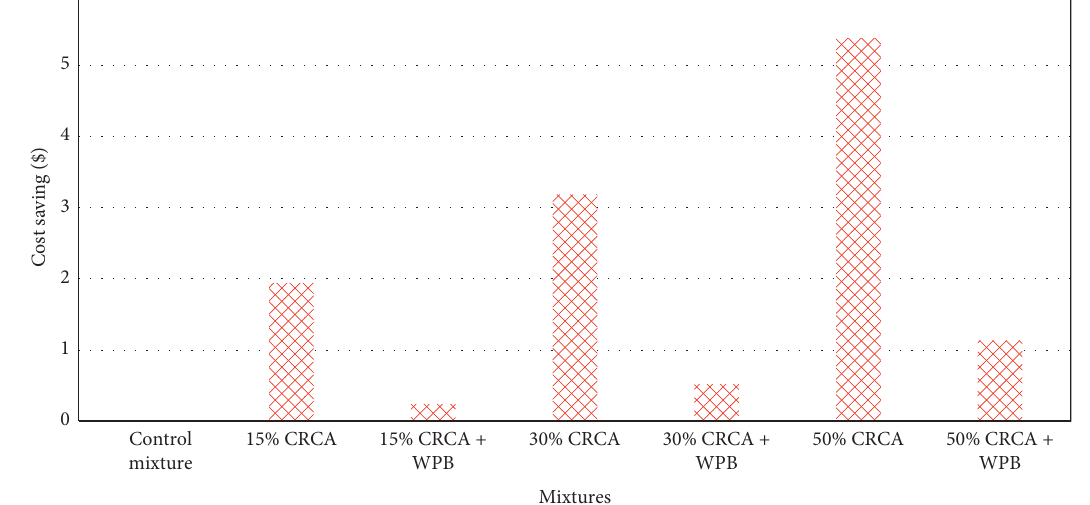
Figure 7: Cost-savings for producing asphalt mixes containing different amounts of CRCA compared to the control mixture at a volume of 1m 3